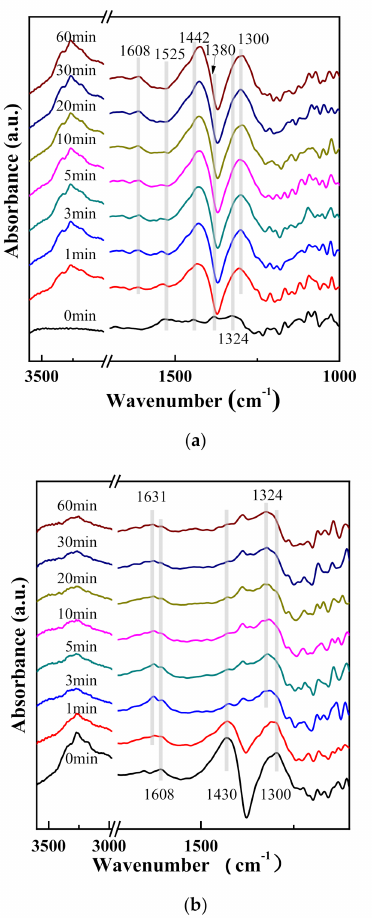
Figure 8. In situ DRIFT spectra of ( a ) NH 3 reacted with preadsorbed NO + O 2 and ( b ) NO + O 2 reacted with preadsorbed NH 3 on Fe /